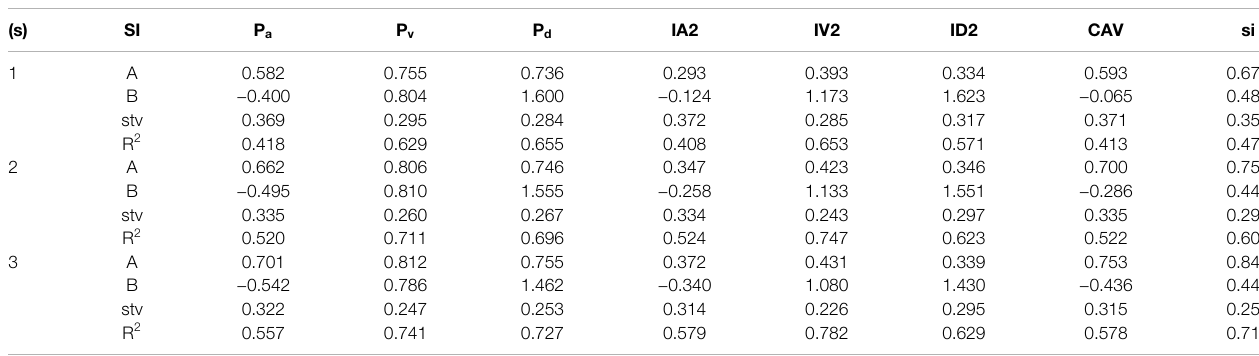
TABLE 5 | Regression coef fi cients of the characteristic parameters and